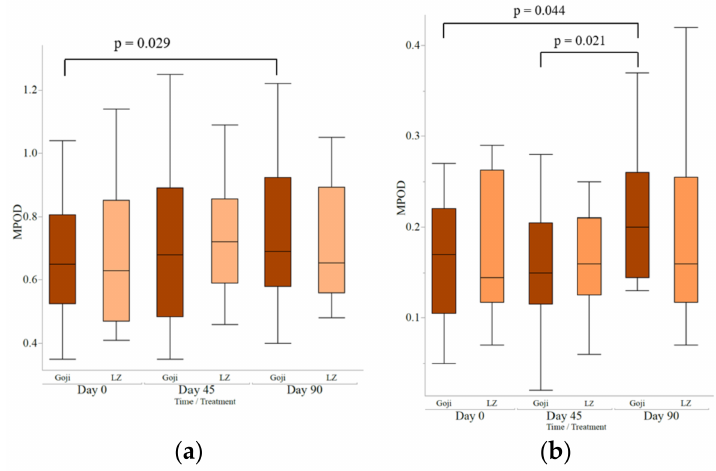
Figure 2. ( a ) Three months of goji berry intake increased macular pigment optical density (MPOD) at 0.25 retinal eccentricity (RE) degrees, at Day 90 compared to baseline (Day 0) and at day 45. ( b ) Three months of goji berry intake increased macular pigment optical density (MPOD) at 1.75 retinal eccentricity (RE) degrees, at Day 90 compared to baseline and at day 45. Statistical analysis performed by mixed models using time and treatment as the main factors, and age and sex as the covariates with Student’s t -test for pairwise comparisons; boxplots are the median and interquartile range.